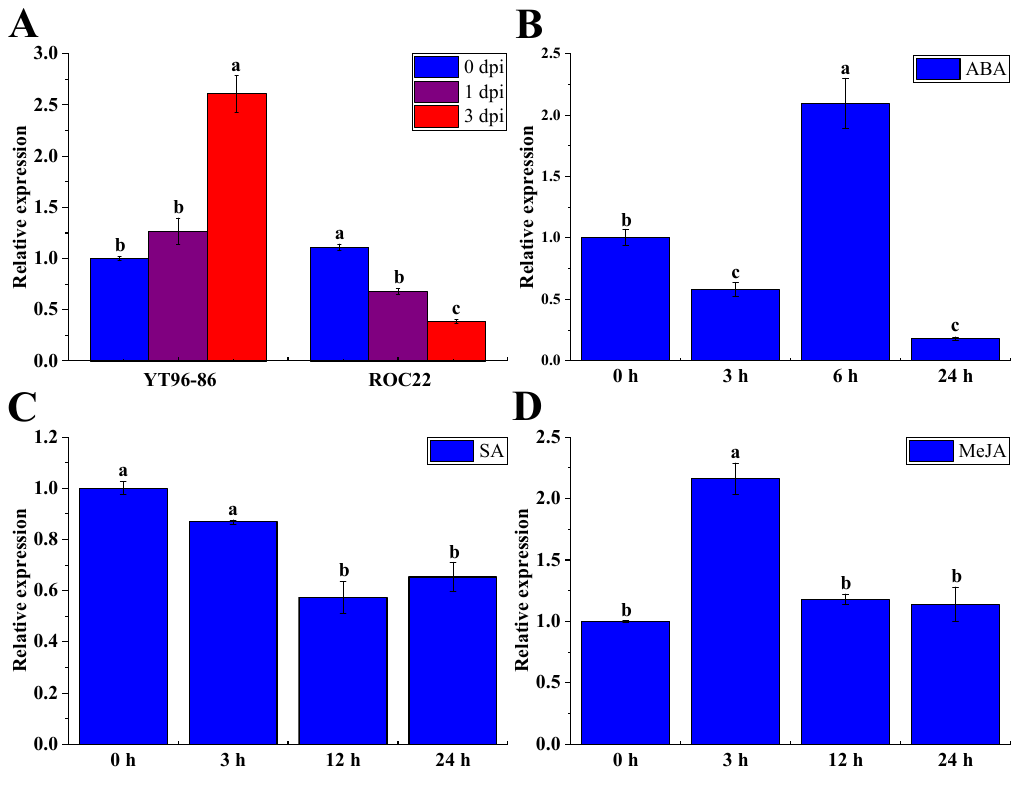
Figure 9. Expression patterns of ShNPR1 in different stress conditions by qRT-PCR analysis. ( A ) Relative expression of ShNPR1 in sugarcane after inoculation with Sporisorium scitamineum . YT96-86 was a sugarcane smut-resistant variety. ROC22 was a sugarcane smut-susceptible variety. dpi: days post-inoculation. ( B – D ) Relative expression of ShNPR1 in 4-month-old ROC22 plantlets under abscisic acid (ABA), salicylic acid (SA), and methyl jasmonate (MeJA) stresses. The leaf samples treated with SA and MeJA were harvested at 0 h, 3 h, 12 h, and 24 h, while those treated with ABA were collected at 0 h, 3 h, 6 h, and 24 h. The expression level of glyceraldehyde-3-phosphate dehydrogenase ( GAPDH ) was used for data normalization. The bars represent the mean ± standard error ( n = 3). Different lowercase letters on the top of the bars indicate the significant differences determined by Duncan’s new multiple range test ( p -value < 0.05).